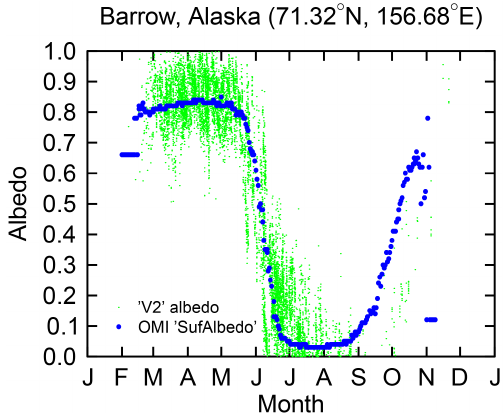
Figure 10. Comparison of effective surface albedo a eff derived from ground-based measurements (“V2” albedo, green marker) with Su- fAlbedo (blue marker) of the OMI climatology for Dis < 12km. a eff data were measured between 1991 and 2013. a eff data between September and November are sparse because of few clear-sky days during this period. The ticks on the x axis indicate the start of a given